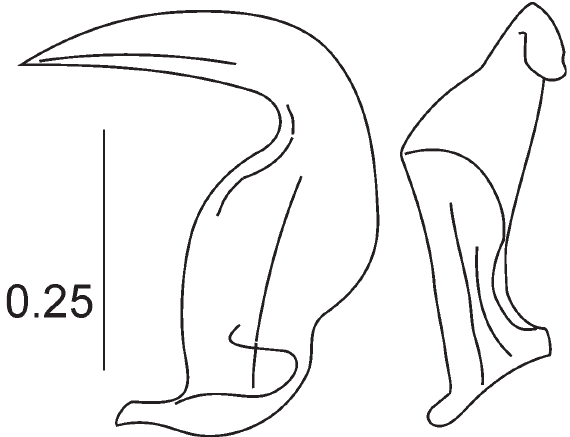
Figure 13 - Parvacinocoris stehliki (Doesburg, 1966), n. comb. Parameres. From Doesburg with the last two segments darker. Hemelytra dull brown without conspicuous paler markings. legs brown with dark areas at apex of femora, base and apex of tibiae and tarsi. vines (Doesburg 1966).